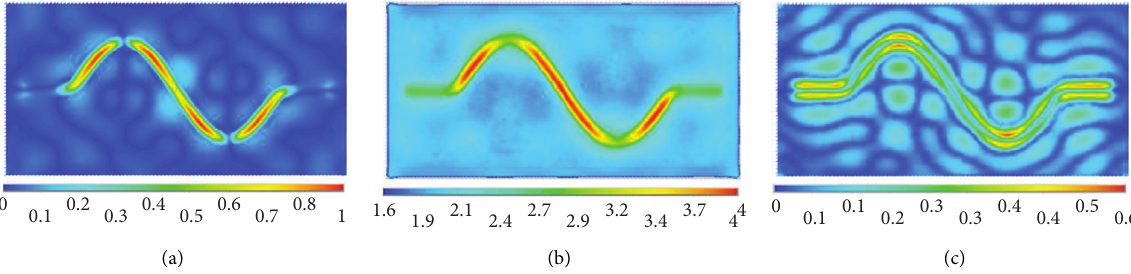
Figure 61: SH wave incident (NR � 2, f � 1.5.0Hz, H � 100m, and C